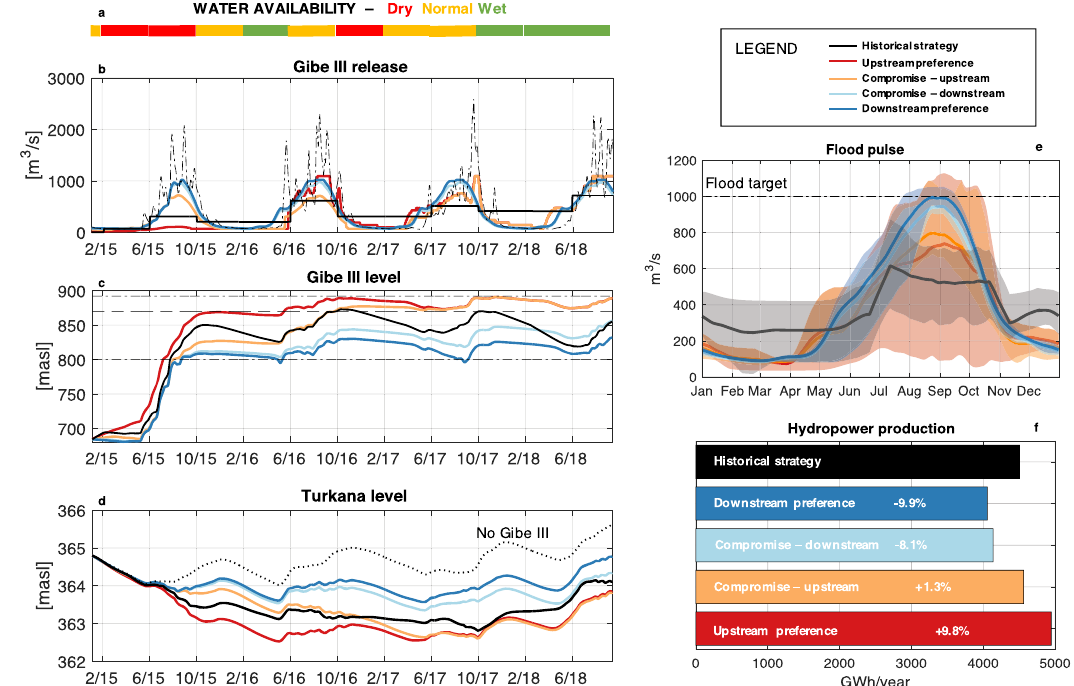
Fig. 4 Adaptive fi lling strategies can reduce fi lling impacts. The seasonal forecasts of Standardized Precipitation and Evaporation Index expressed in terms of dry, normal, and wet conditions with respect to seasonal average ( a ) inform the designed adaptive fi lling strategies ( b , c ). Different colors correspond to adaptive strategies with different tradeoffs between upstream and downstream competing interests, blues for more environmental inclined, and reds for hydropower inclined strategies, while the historical strategy is represented in black. Adaptive strategies demonstrate the ability to signi fi cantly reduce downstream impacts on Lake Turkana ( d ) and average river hydrology ( e , where the shaded areas refer to the interannual variability) while remaining within a contained range of historically produced hydropower. The numerical labels in the barplot of f quanti fi es the percentage difference in hydropower production associated with adaptive strategies normalized to the historical production. This fi gure illustrates 4 representative adaptive solutions, compared to the historical solution in black. The complete set of adaptive policies resulted from the optimization is reported in